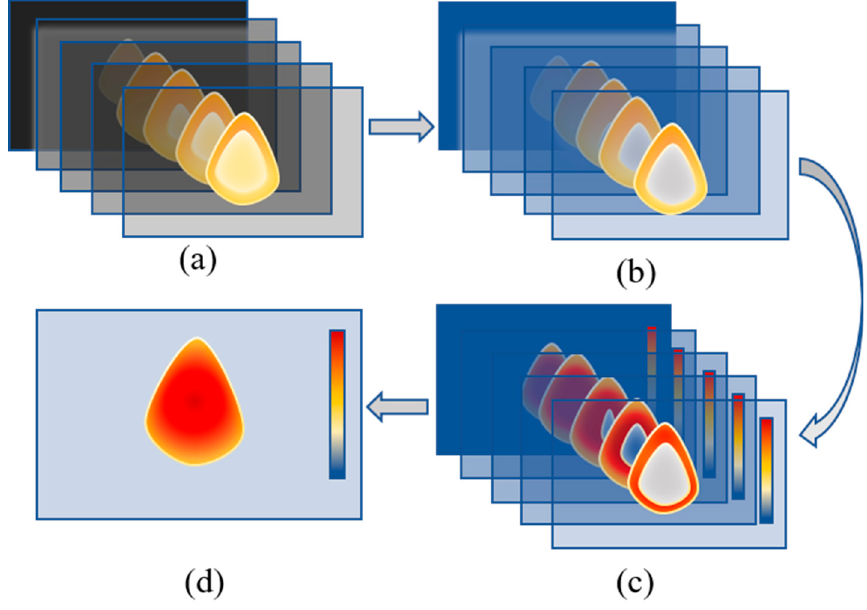
Figure 1. Image fusion temperature measurement. ( a ) initial flame radiation images; ( b ) flame radiation images with only retained valid areas; ( c ) flame temperature distributions of effective temperature measurement areas; and ( d ) complete flame temperature distribution.